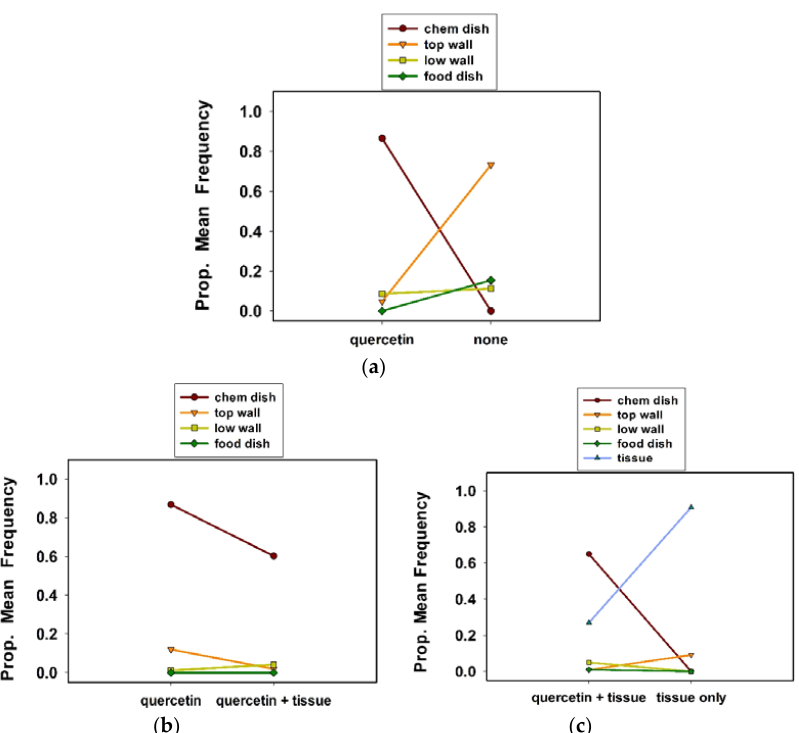
Figure 3. Proportional mean frequency of C . maculata egg clutches at sites in response to treatments in solitary cages in experiment 1 ( a ), experiment 2 ( b ), and experiment 3 ( c ).